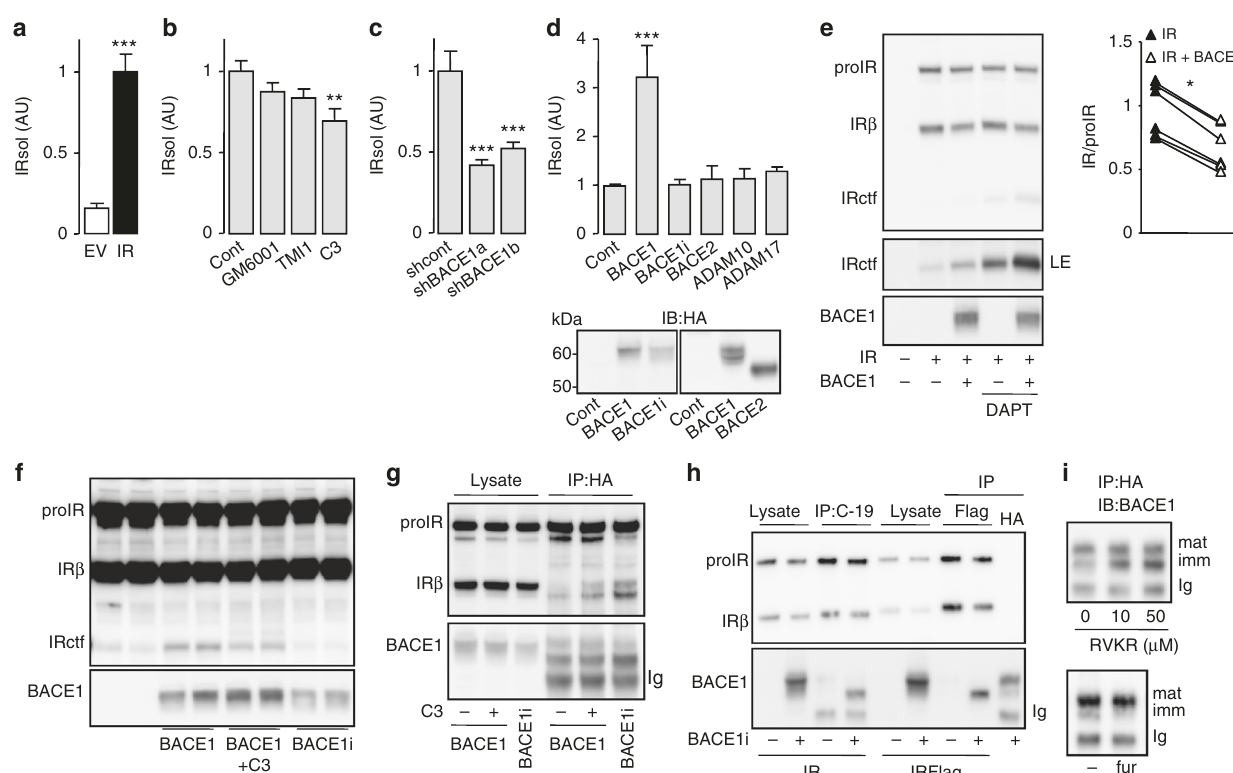
Fig. 2 BACE1 is involved in IR cleavage. IRsol was measured by ELISA in 24 h conditioned media of a HEK 293 cells transfected with an empty vector (EV) or overexpressing IR. The mean IRsol values from IR overexpressing cells were arbitrarily set at 1. b Cells overexpressing IR and untreated (Cont) or treated with the indicated protease inhibitors (10 μ M, 24 h). c Cells overexpressing IR together with BACE1 speci fi c shRNA (shBACE1a, shBACE1b) or a control shRNA (shcont). d Cells transfected with the IR expression vector together with an empty plasmid (Cont), BACE1, inactive BACE1 (BACE1i), BACE2, ADAM10, or ADAM17. Expression of BACE1 and BACE2 were con fi rmed by immunoblot, using HA antibody (lower panel). e Cells transfected with combinations of IR and BACE1 expression vectors were treated or not with DAPT, then IR and BACE1 were detected by immunoblot. LE indicates a long exposure of the immunoblot. The graph shows the ratios IR/proIR obtained from the quanti fi cation of six independent experiments; data from the same experiment are connected by a line. f Cells overexpressing IR and BACE1 or inactive BACE1 (BACE1i) were treated with the BACE1 inhibitor (C3) then IR and BACE1 were detected by immunoblot. g Cells were treated as f , then BACE1 was immunoprecipitated (IP) with anti HA antibody and IR, and BACE1 were detected by immunoblot in cell lysates and immunoprecipitated fractions. h Cells were transfected with the indicated combinations of IR, IRFlag, and BACE1i expression vectors, then overexpressed proteins were immunoprecipitated using C-19, FlagM2 (Flag) and HA antibodies, respectively, and detected by immunoblots. i BACE1 overexpressing cells treated with proprotein convertase inhibitor dec-RVKR-cmk (RVKR; 24 h; upper panel) or cells overexpressing BACE1 without ( − ) of with furin (fur; lower panel) were lyzed then BACE1 was immunoprecipitated and detected by immunoblot. Positions of the heavy chain of the precipitating antibody (Ig), immature (imm) and mature (mat) BACE1 are indicated. Data are means ± s.d. Statistical analyses were made using unpaired t -test ( a , e ) or ANOVA followed by Dunnett ’ s test ( b – d ); ** p < 0.01; *** p <